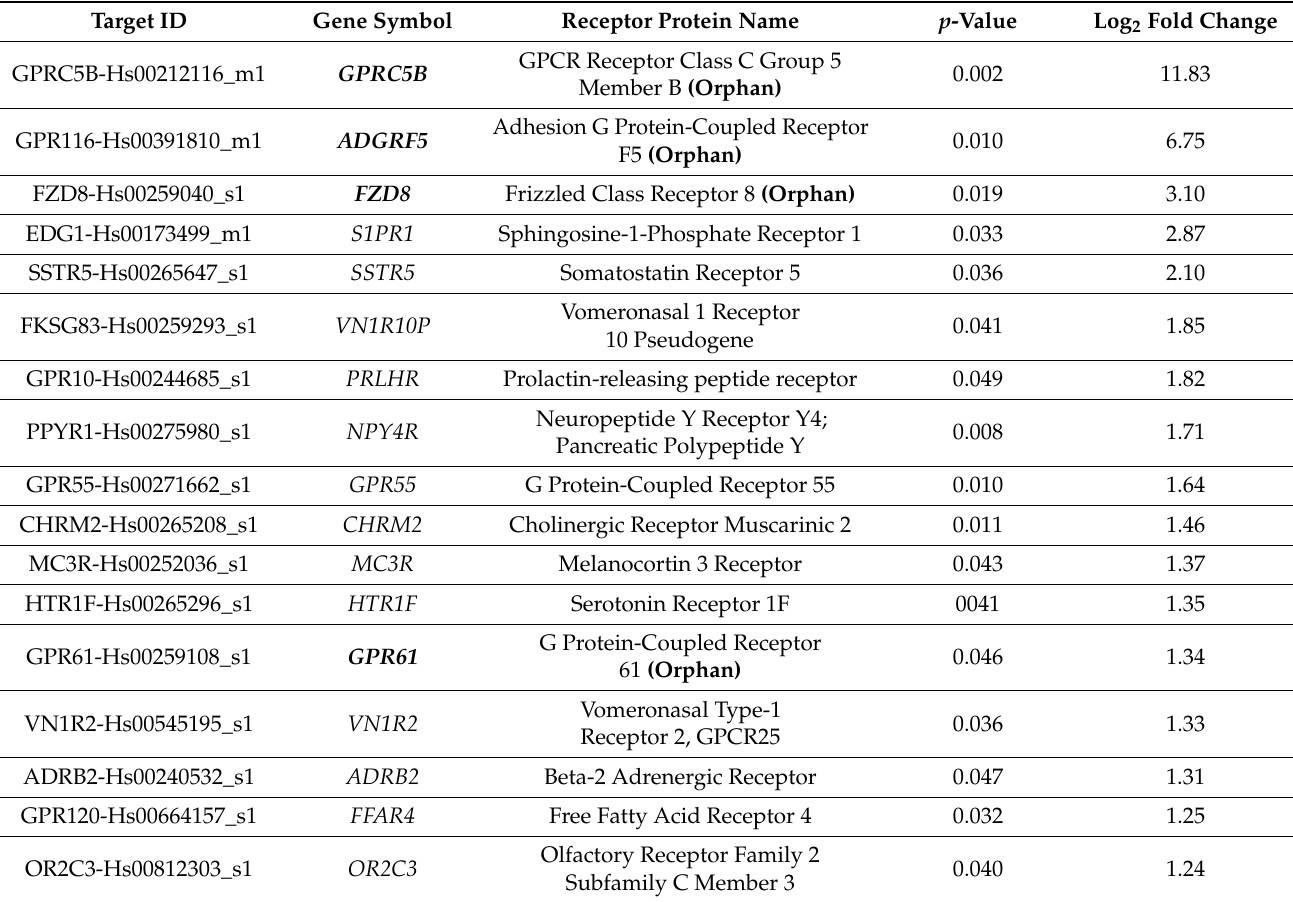
Table 1. Significantly upregulated GPCRs in human dermal lymphatic endothelial